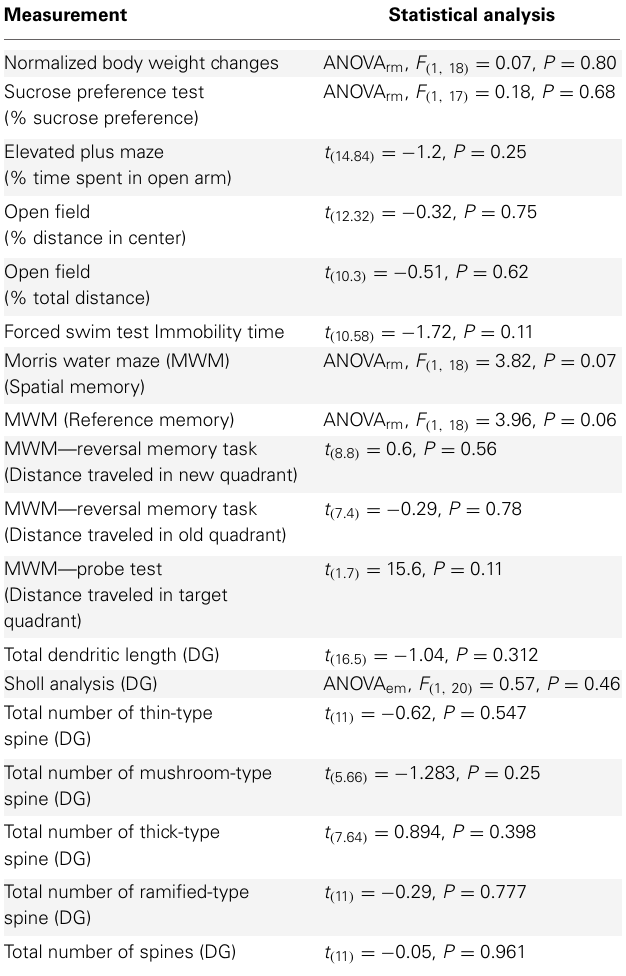
Table 1 | Statistical analysis of two control (normal and inverted light) groups together.